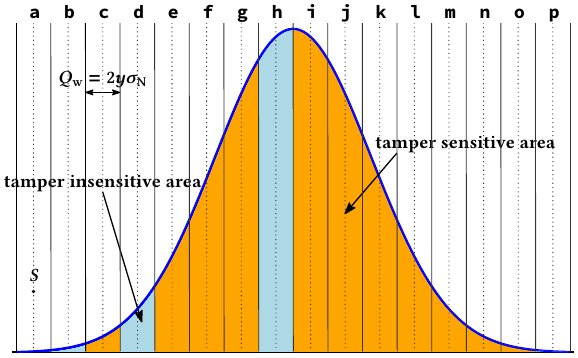
Figure 5: TS max of Profile 3. Please note that for Gray encoded symbols, the resulting node distance d ( a, p ) = 1, due to how a Gray code is typically H | 2